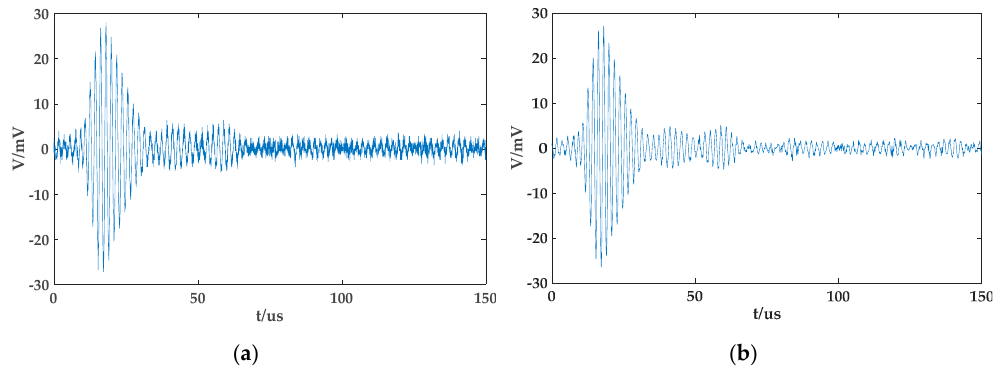
Figure 14. Signal processing: ( a ) Original waveform; ( b ) waveform filtered by EMD.